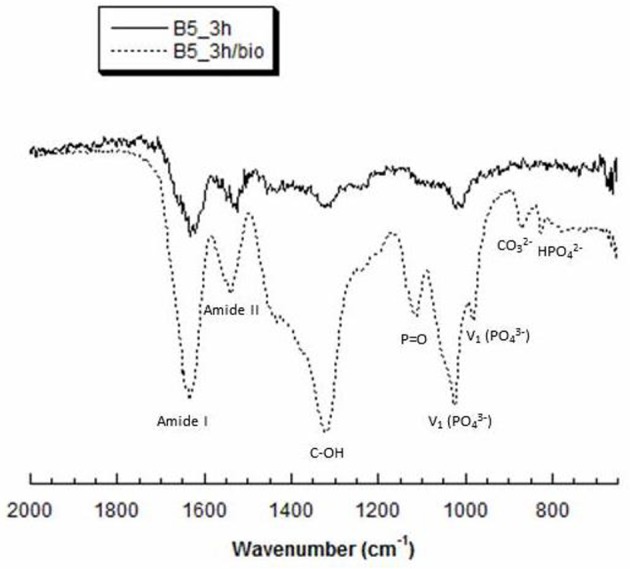
Representative ATR-FT IR spectra of B5 scaffolds, before (B5_3h) and after (B5_3h/bio) biomimetic treatment.